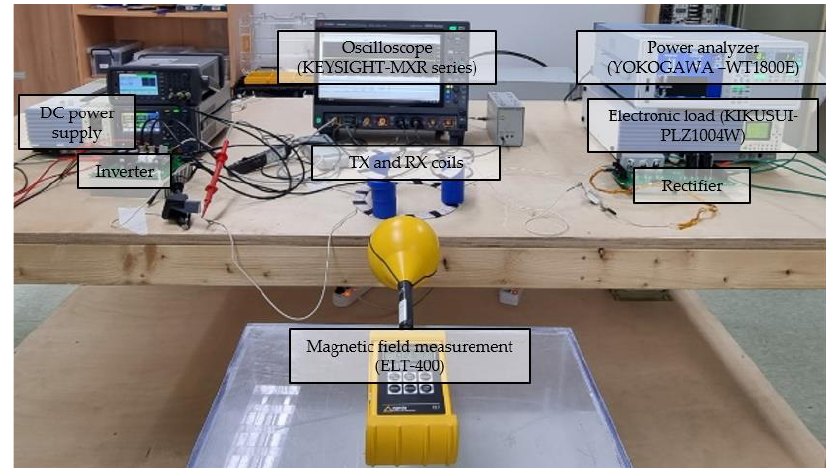
Figure 16. Setup for experimental verification. Table 5. Electrical parameters for verification through experiment.